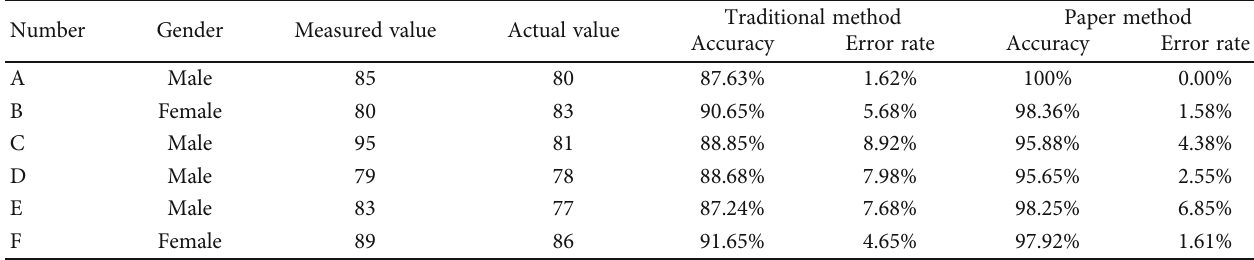
Table 7: Comparison of average blood pressure assessment results of big data.